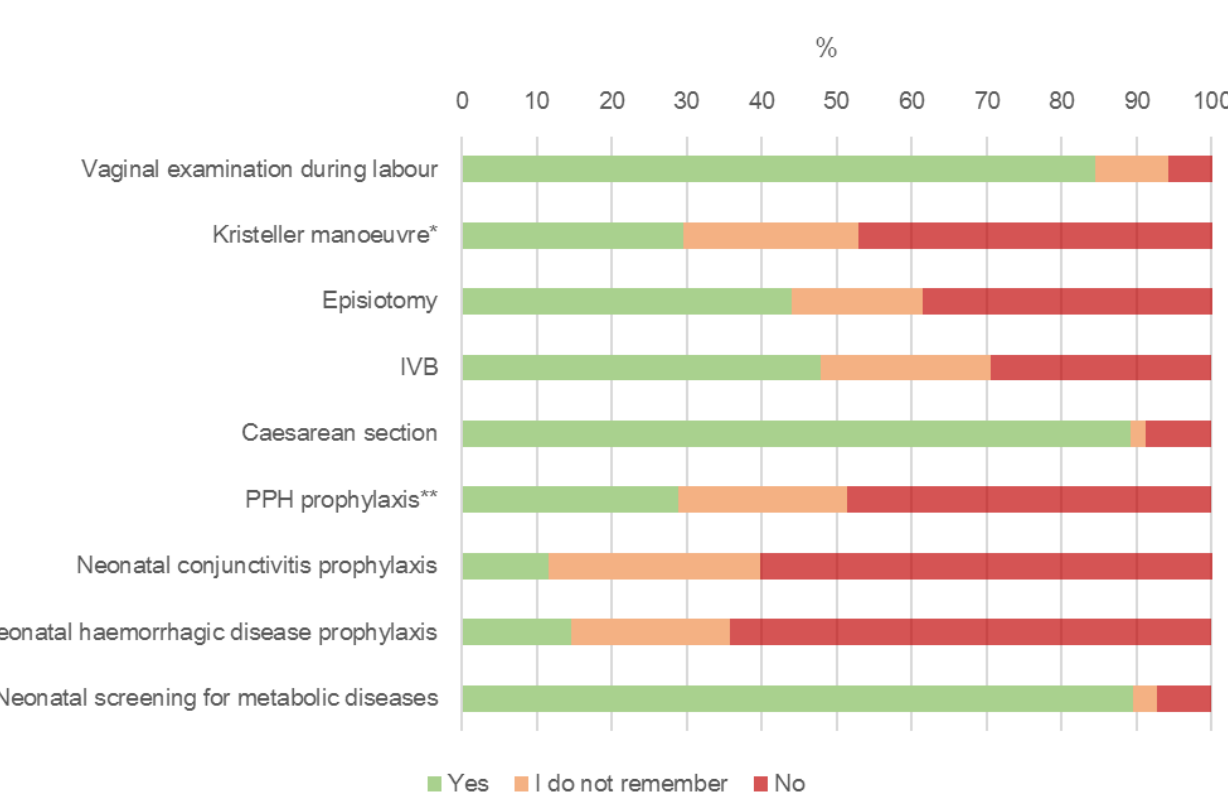
Figure 1. Consent request by type of clinical procedure according to women’s perception. Notes: All procedures were related to one or more WHO standards; * fundal pressure during second stage of labour as perceived by women; ** data generated only by women who had a vaginal birth or instrumental vaginal birth. Abbreviation: IVB = instrumental vaginal birth; PPH = maternal post-partum haemorrhage.